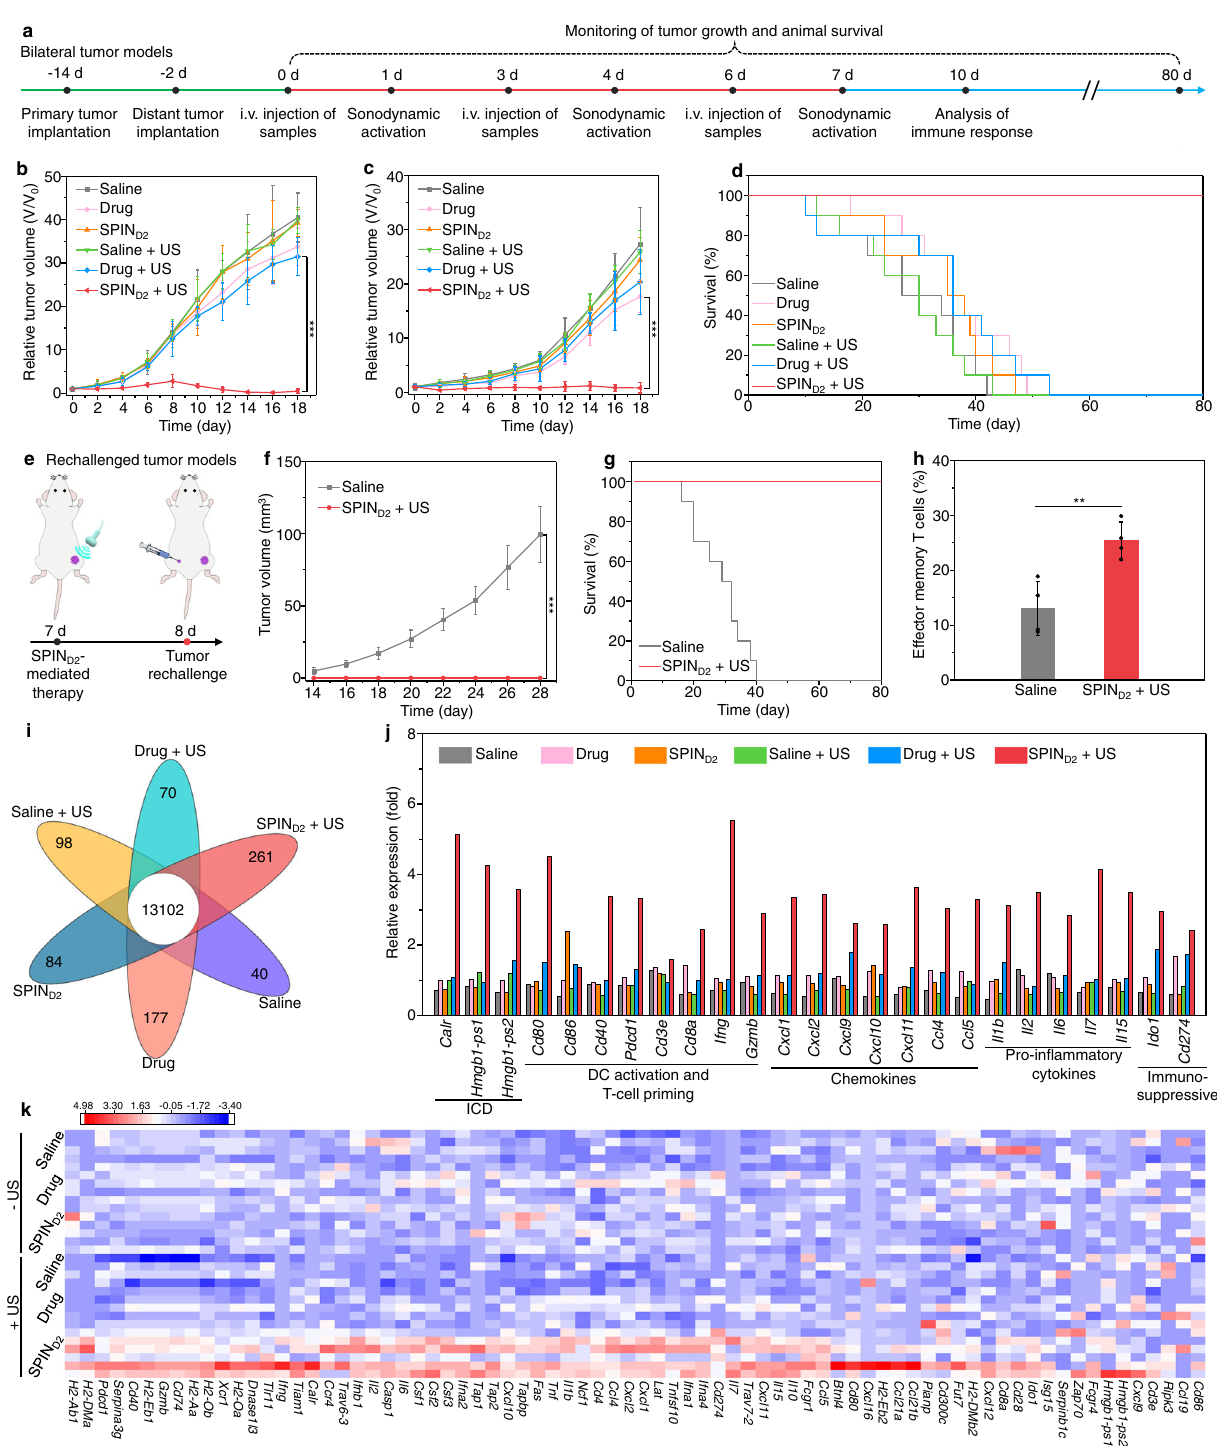
opposite fl ank (Fig. 4e). Note that the volume of rechallenged and US-irradiated mice was 33, 35, 39, and 46 days, respectively tumors in the saline-injected control mice gradually increased, (Fig. 4d and Supplementary Fig. 36). More importantly, the while no rechallenged tumors were observed for mice after SPIN D2 survival of mice was still 100% after SPIN D2 injection and US injection with US irradiation (Fig. 4f). All saline-injected control irradiation for 80 days. These results suggested that SPIN D2 - mediated treatment showed the highest ef fi cacy in inhibiting the mice after tumor rechallenge died within 40 days (Fig. 4g). In growths of primary and distant metastatic tumors and prolonging contrast, the SPIN D2 -injected and US-irradiated mice exhibited a the survival of mice. 100% survival for 80 days even after tumor rechallenge. The To further con fi rm the superior antitumor ef fi cacy of SPIN D2 - population of effector memory T cells in spleen of SPIN D2 -injected mediated sono-immunotherapy, the tumor-bearing mice after and US-irradiated mice was 25.5%, which was 1.9-fold higher than treatment were rechallenged with Panc02 tumor cells on the that for the control mice (Fig. 4h and Supplementary Fig. 37). This NATURE COMMUNICATIONS| (2022) 13:4032